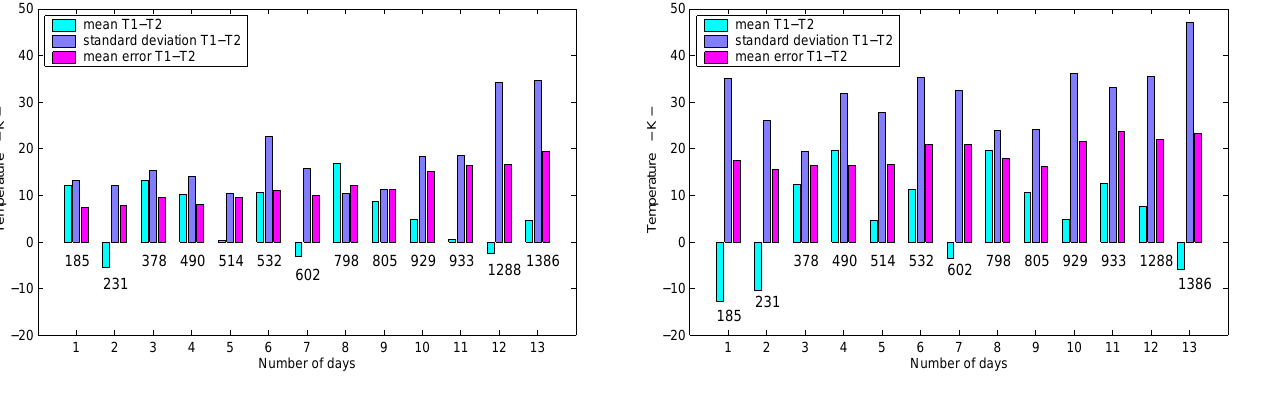
Fig. 4. Mean apparent temperature differences between the two FOVs for 13 days, averaged over the tangent altitude range of 180 to 260km. The standard deviations of the differences and the mean errors are also indicated.